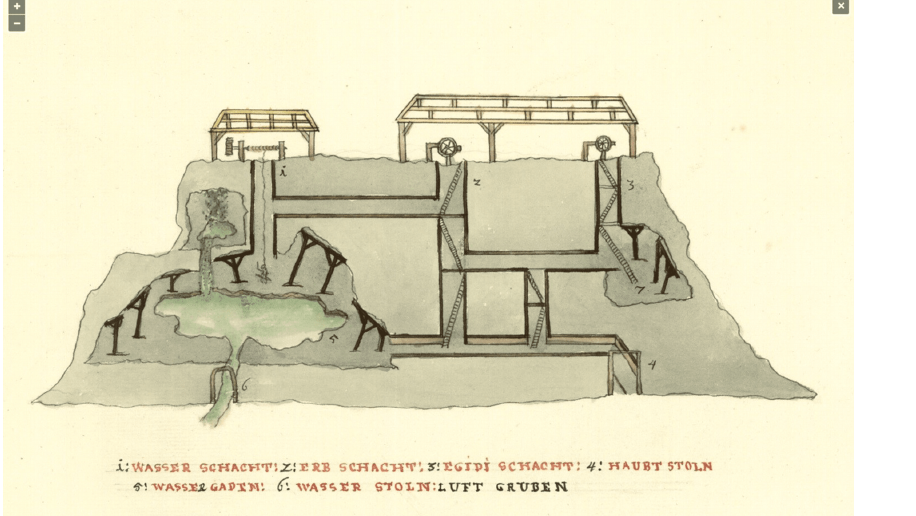
Figure 4. A cut-out from the Geyer map (1751) schematically illustrating the mining of cementation water in the mining underground and its pumping to the surface (source: the Moravian Library in Brno, 2020, Czech Republic; the copy of the map was obtained in